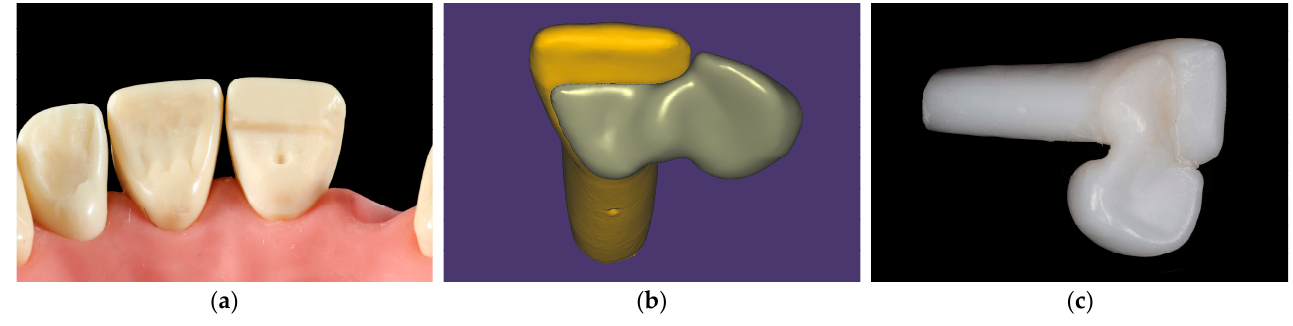
Figure 1. Fabrication of zirconia abutment tooth and zirconia RBFDP. ( a ) Non-retentive preparation of typodont central maxillary incisor for RBFDP; ( b ) scanned abutment tooth and designed complementary zirconia RBFDP; ( c ) milled and sintered zirconia abutment tooth and complementary RBFDP. RBFPD , resin-bonded fi xed dental prosthesis.